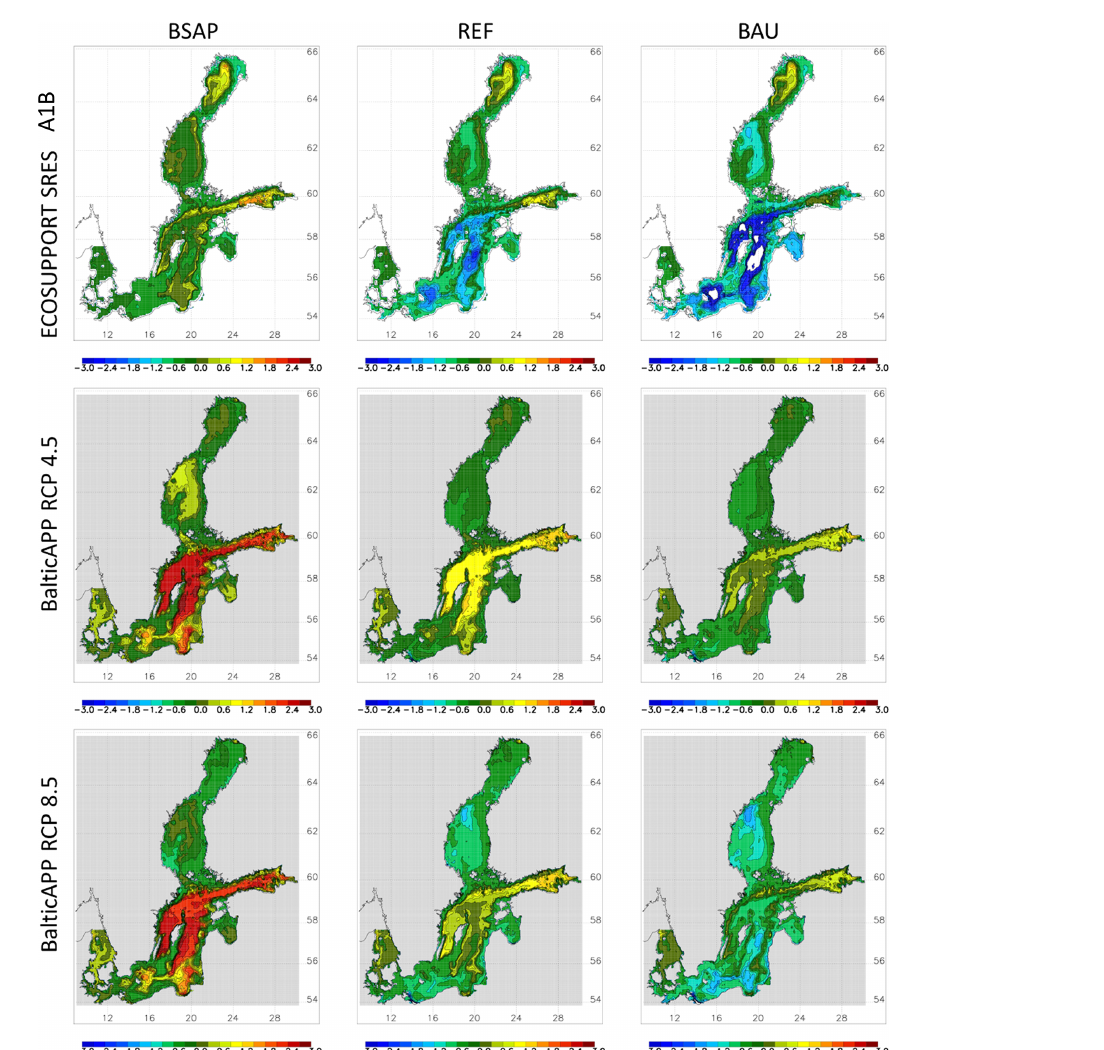
Figure 21. Ensemble mean changes in the bottom dissolved oxygen concentration (mLL − 1 ) in summer (June–August) between 1978–2007 and 2069–2098. From left to right, the results of the nutrient input scenarios of BSAP, REF and BAU. From top to bottom, the results of the ensembles ECOSUPPORT (white background; Meier et al., 2011b), BalticAPP RCP4.5 (grey background; Saraiva et al., 2019a) and BalticAPP RCP8.5 (grey background; Saraiva et al.,